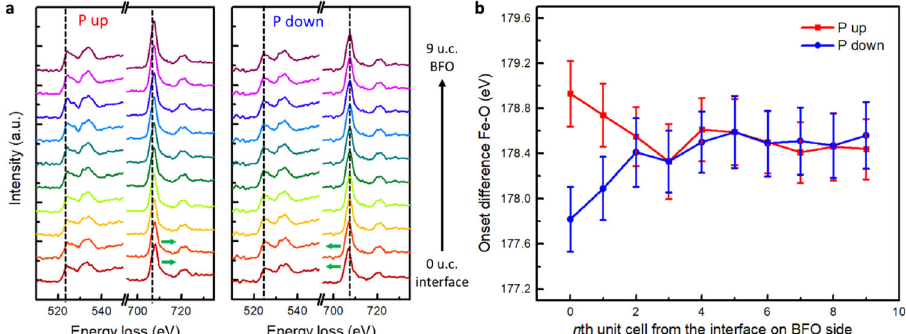
Fig. 4 EELS measurements at the two BFO/TSO interfaces. a Core-loss EELS of oxygen K-edge and Fe L 2 and L 3 edges line scans collected from the interfaces with upward (left) and downward (right) polarization states to the bulk BFO. The black dashed lines represent the peak positions of the fi rst peak of O K edge and Fe L 3 edge in the bulk regions. Green arrows indicate the energy shift directions. b The energy onset difference between the O K and Fe L 3 edges measured from the BFO/TSO interfaces to the bulk BFO. The onset energy values of O K and Fe L 3 edges are de fi ned as the energy loss reaches 10% of their intensities based on the spectrums in ( a ). The error bars denote the standard errors in peak fi tting for fi nding the onset energy of the O K and Fe L 3